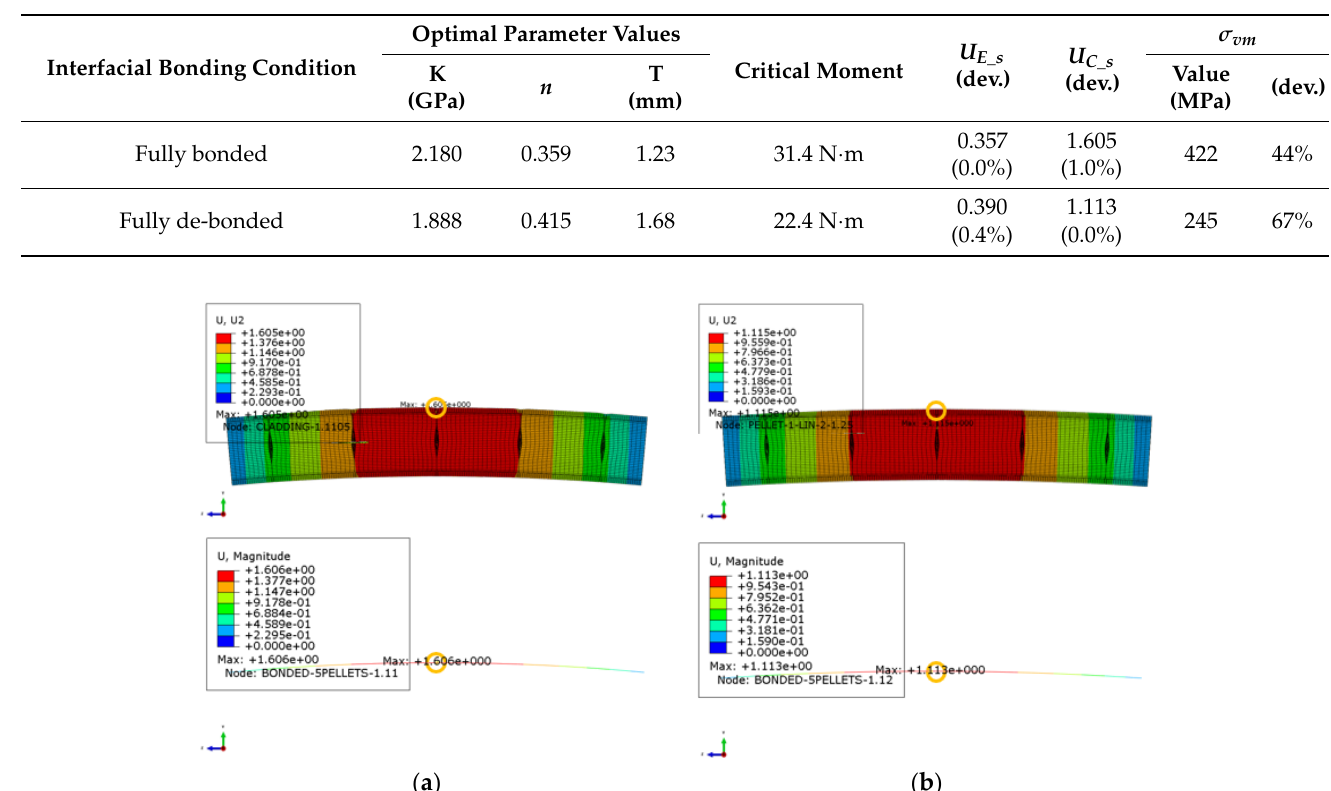
Table 4. Results of the beam model parameter calibration.